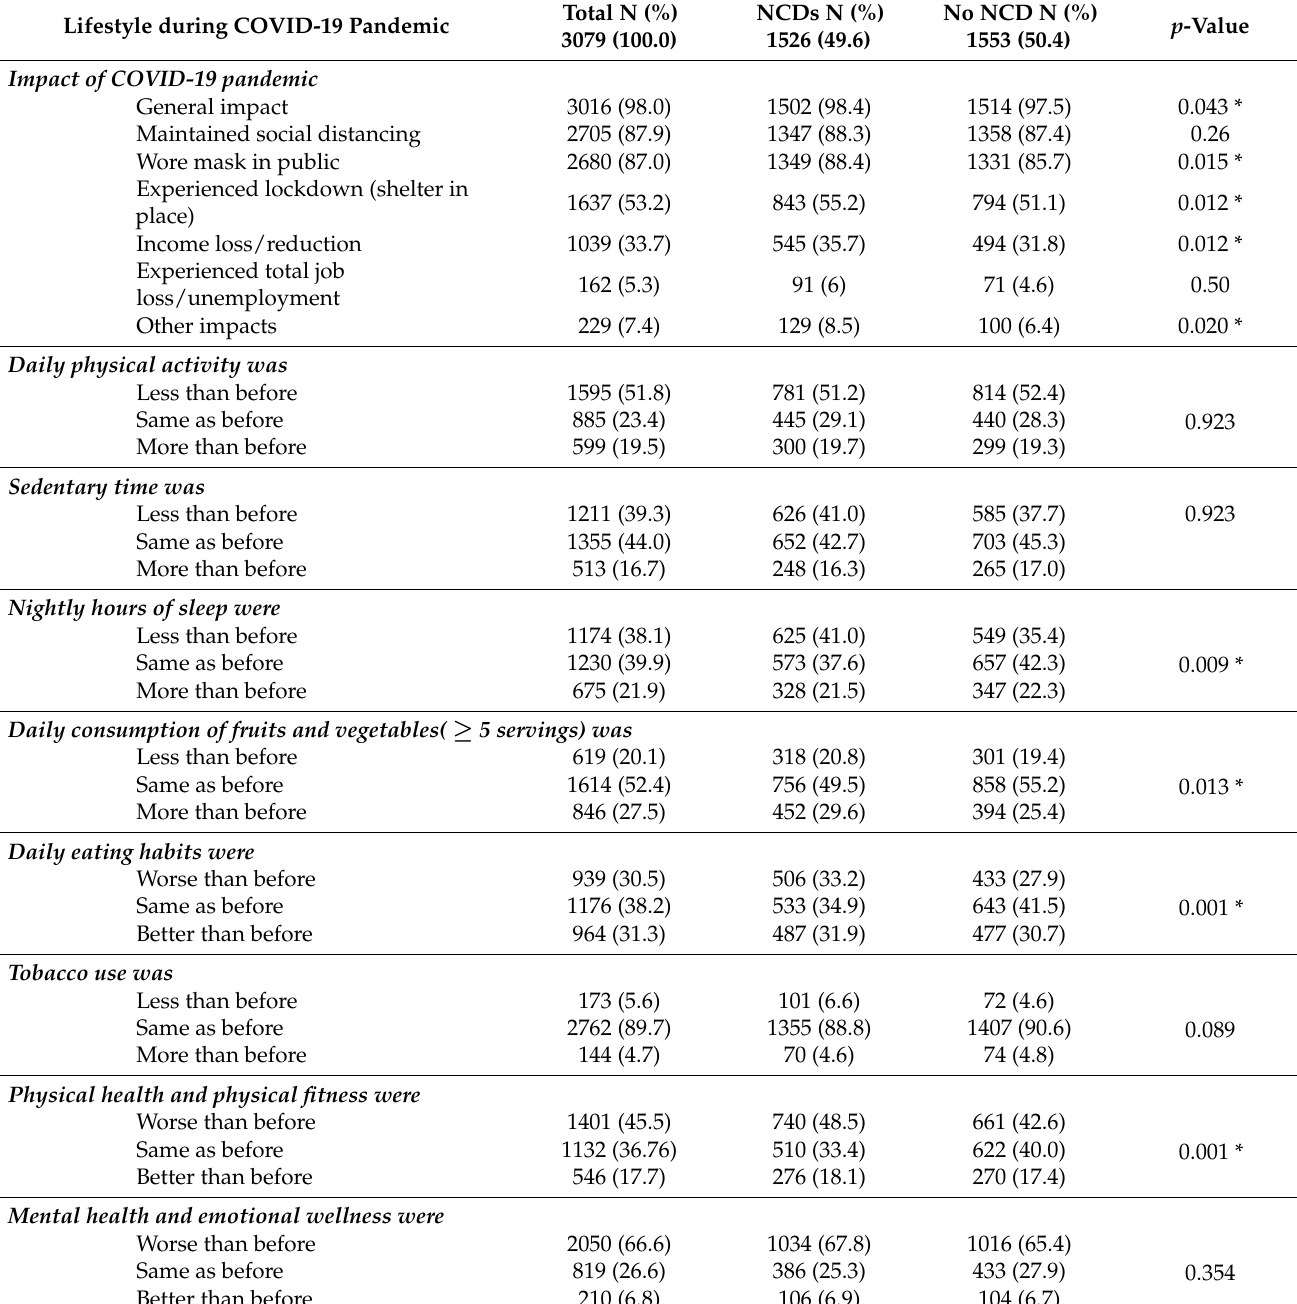
Table 3. Daily life changes and healthy lifestyle behaviors in people with and without NCD during the COVID-19